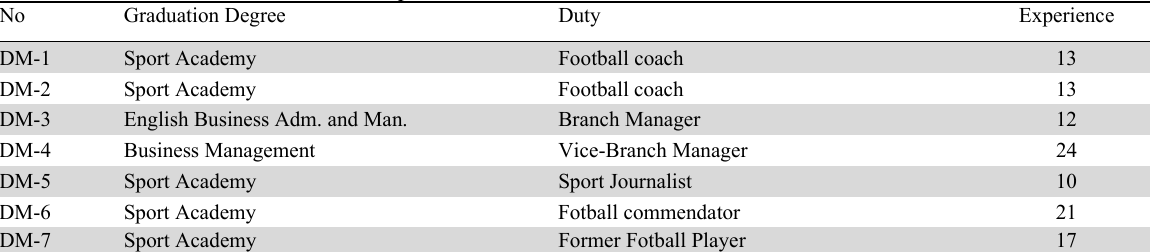
Details of the Members of the Board of Experts.